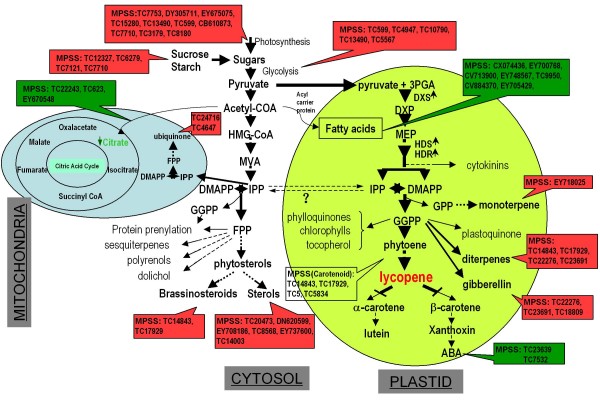
Overview of major metabolic pathways involved in the mutant trait formation, as suggested by the interpretation of the GO and MPSS data. Part of the model was modified from Figure 1 of Rodriguez-Concepcion (2006) [62]. The box background in red indicates up-regulated genes, and green indicates down-regulated genes. The genes are designated as TC numbers from TIGR gene index database, and the detailed gene information can be viewed in additional file 6. The TC numbers for LYCb and CCS genes were TC5 and TC5834 respectively. The abbreviations are as follows: 3PGA, glyceraldehyde 3-phosphate; ABA, abscisic acid; DMAPP, dimethylallyl diphosphate; DXP, deoxyxylulose 5-phosphate; DXS, deoxyxylulose 5-phosphate synthase; FPP, farnesyl diphosphate; GPP, geranyl diphosphate; GGPP, geranylgeranyl diphosphate; HDR, hydroxymethylbutenyl 4-diphosphate reductase; HDS, hydroxymethylbutenyl 4-diphosphate synthase; HMG-COA, hydroxymethylglutaryl coenzyme A; IPP, isopentenyl diphosphate; MEP, methylerythritol 4-phosphate; MVA, mevalonic acid.